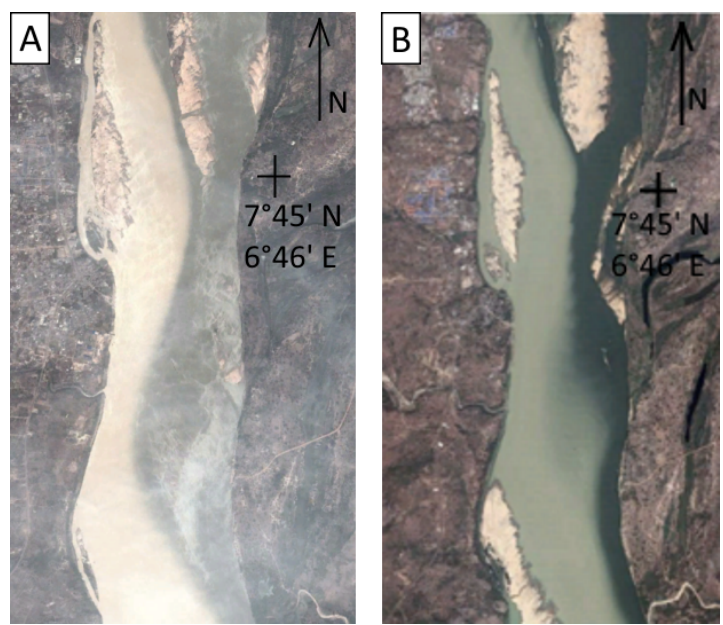
Figure 1. Aerial photographs of the Niger–Benue confluence on ( A ) 5 December 2011 and ( B ) 21 December 2005. Flows are from top to bottom. The lighter colored Niger water is on the left, and the darker colored Benue water on the right. Source: Google Earth